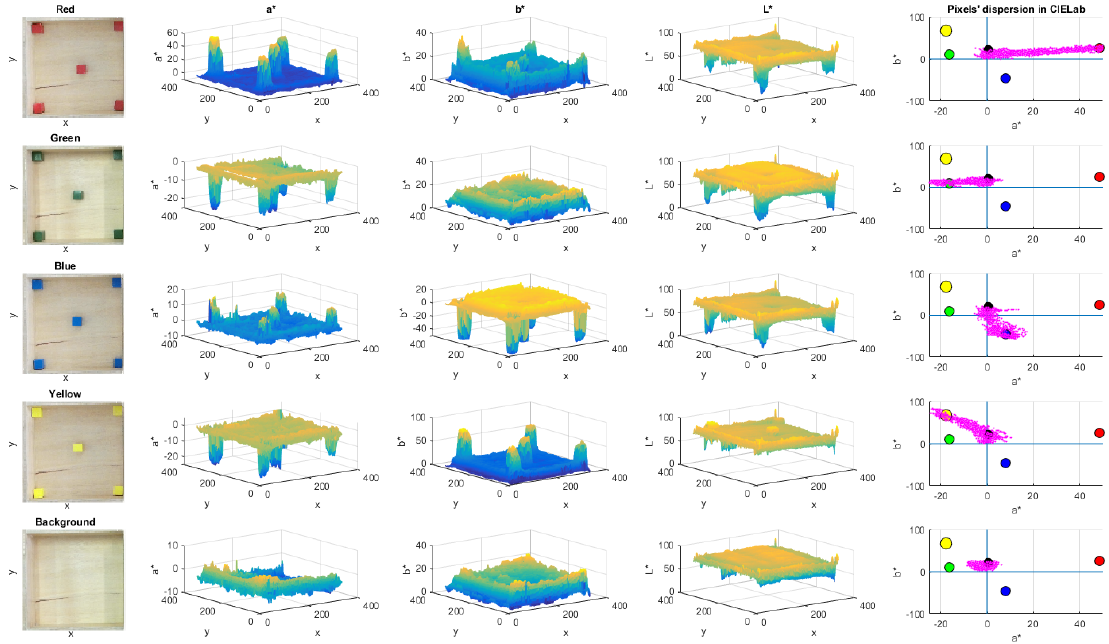
Figure 4. Description of the procedure to define the colour markers. The first column shows the image used for colour calibration (cubes are placed on the corners and the centre of the compartment). Columns 2 to 4 depict the a*, b*, and L* values of the scene, according to the pixel’s location (x,y). The last column describes the colour markers location and the dispersion of the CIELab colour space for each